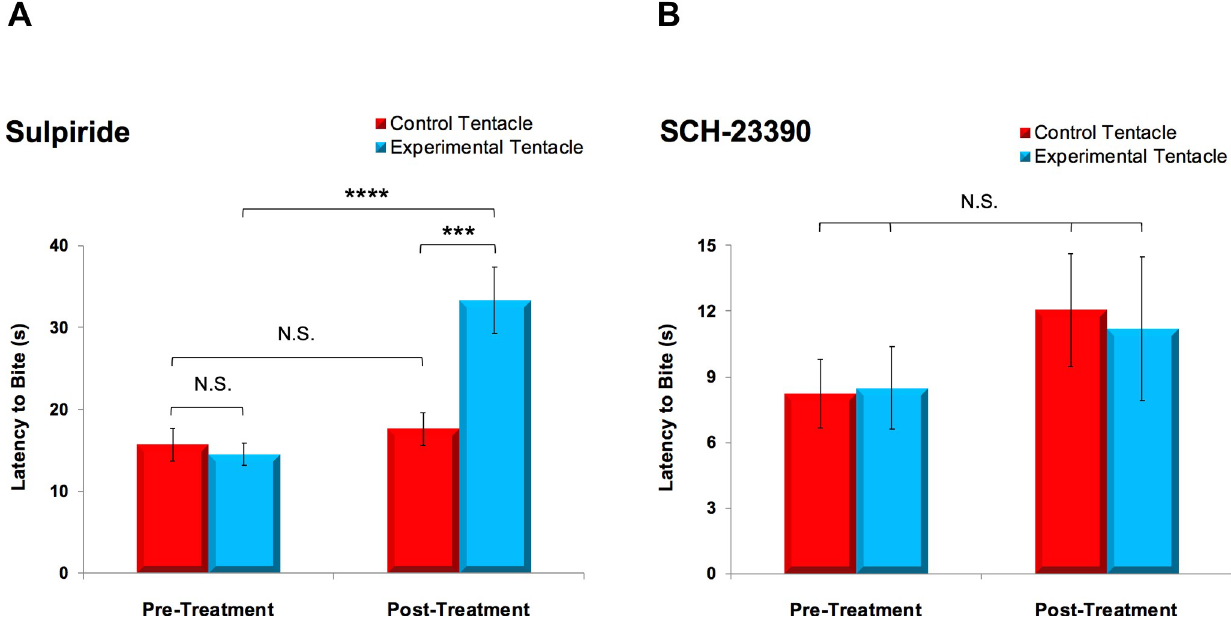
Fig 8. The D 2 /D 3 dopamine antagonist sulpiride increased latency to bite in a food-localization task. (A) Unilateral application of sulpiride to the OVTC of Pleurobranchaea (N = 24) significantly increased the latency to bite at shrimp (two-way repeated measures ANOVA, F (1,23) = 13.28, p = 0.0014). Sulpiride increased latency to bite at stimuli placed on the experimental tentacle by 18.8 ± 3.1 s (mean ± SEM, p < 0.0001), with post-treatment latencies measured on the experimental tentacle 15.7 ± 3.1 s longer than those on the control tentacle ( p = 0.0002). (B) Bite latencies did not significantly change on either side of the OVTC when food was presented to animals (N = 6) treated with the D 1 antagonist SCH-23390 (two-way repeated measures ANOVA, F (1,5) = 1.21, p = 0.321). Individual bars depict means with SEMs. ���� , p < 0.0001; ��� , p < 0.001; N.S. = not significant.